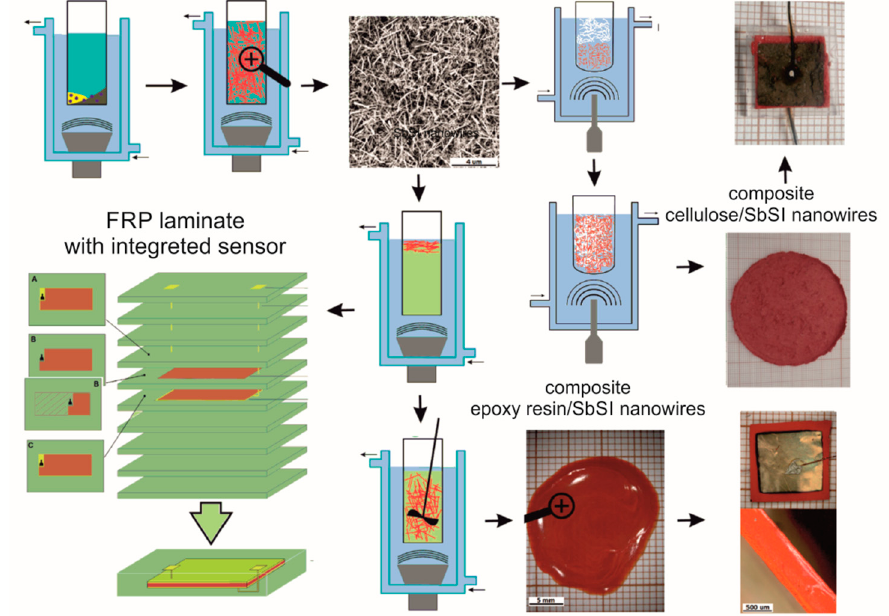
Figure 1. Scheme of sonochemical preparation of SbSI nanowires, the epoxy resin / SbSI nanowire and cellulose / SbSI nanowires composites, generator / sensor assembly, and scheme of FRP laminate with integrated sensor [26,29,31]. Description in the text.